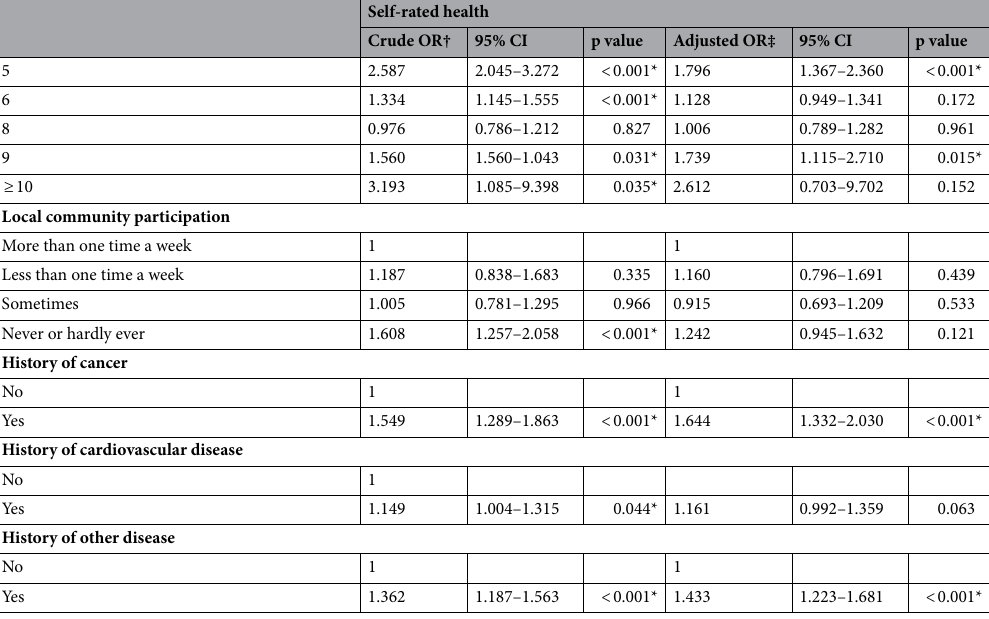
Table 2. Crude and adjusted odds ratios and 95% confidence intervals of the variables associated with self- rated health. BMI body mass index, OR odds ratio, CI confidence interval. † Crude OR for “poor self-rated health (vs. “Excellent”/“Very good”/“Good”). ‡ Adjusted OR for variables with p < 0.05 in the univariate analysis using backward stepwise method. *Statistically significant (p <